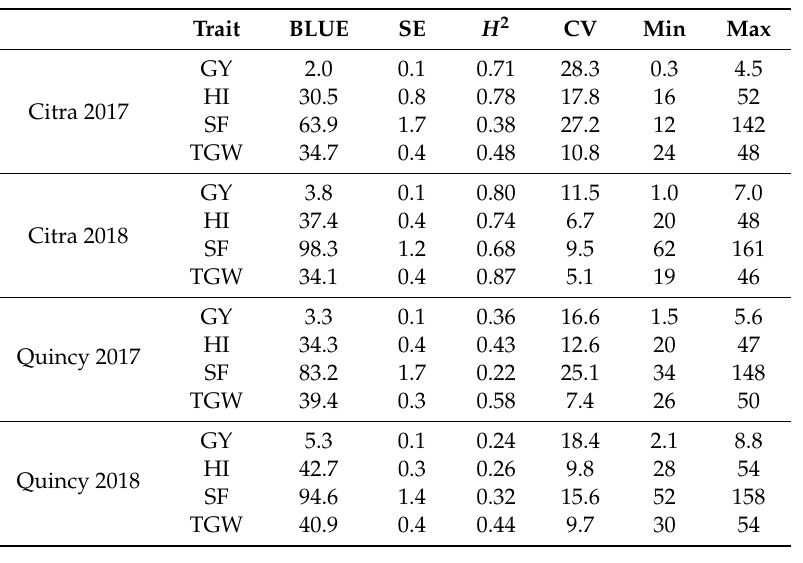
Table 2. Description of grain yield (GY) (ton ha − 1 ), harvest index (HI) (%), spike fertility (SF) (grains / g of cha ff weight), and thousand grain weight (TGW) (g) phenotypic traits † evaluated at Citra, FL and Quincy, FL in 2017 and 2018. The best linear unbiased estimates (BLUEs), standard error (SE), heritability (H2), coe ffi cient of variation (CV), maximum and minimum value were calculated for each trait in four environments.